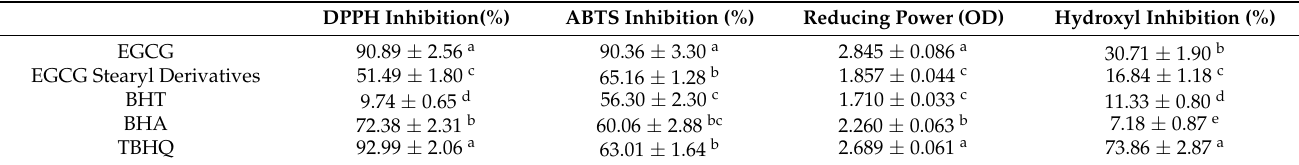
Table 3. Antioxidant Abilities of EGCG, EGCG Stearyl Derivatives, and Synthetic Antioxidants. DPPH